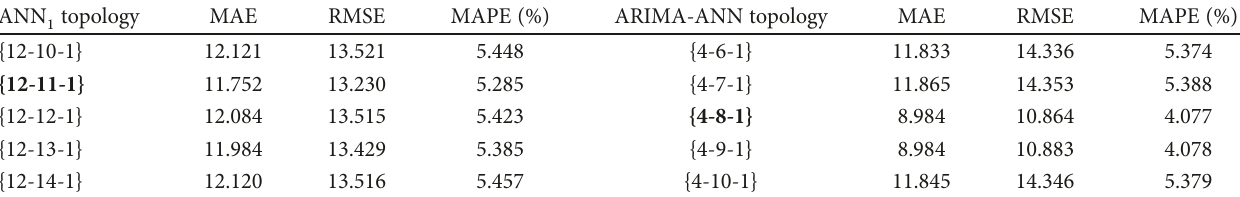
Table 8: Forecast validity measures for two ANN designs (rice price forecasting).